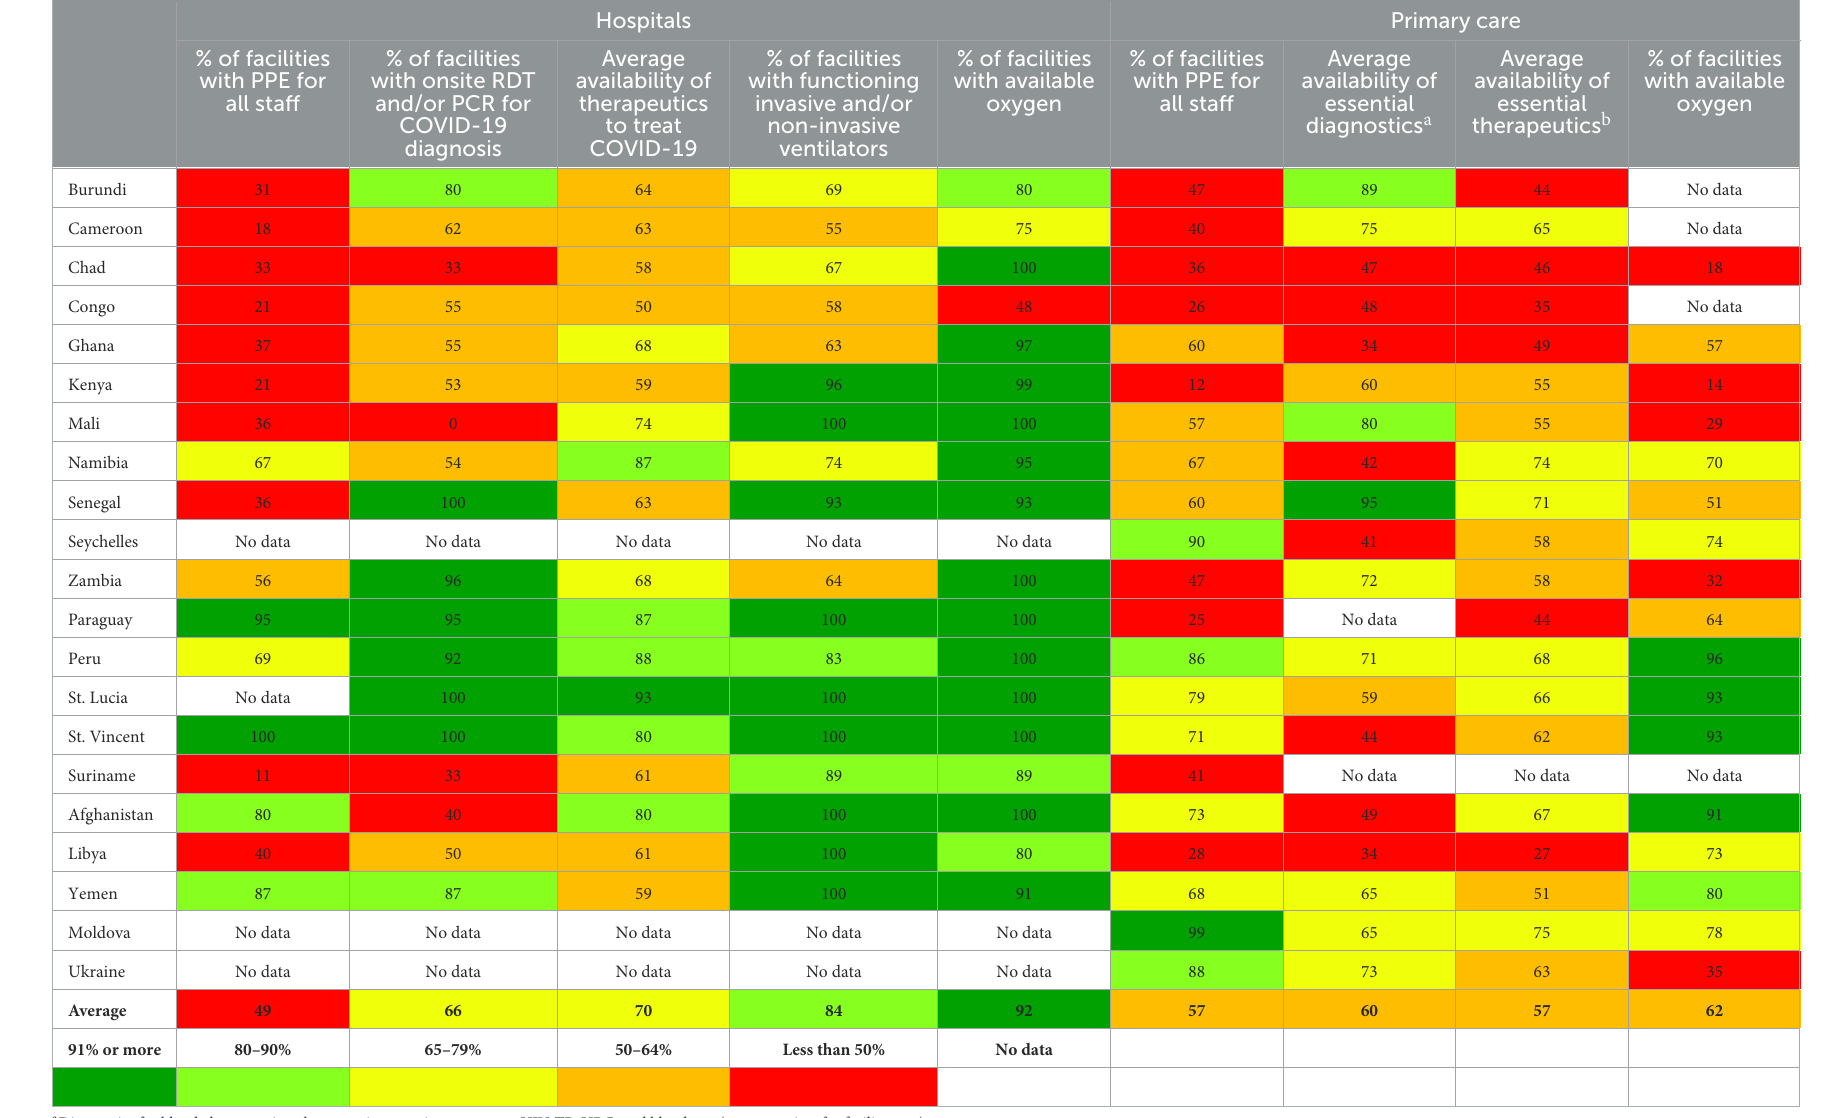
TABLE 1 Availability of essential COVID-19 tools and other essential health products in hospitals ( n = 498, 18 countries) and primary care facilities ( n = 2,377, 21 countries) at the time of assessment, by country (January 2021–March